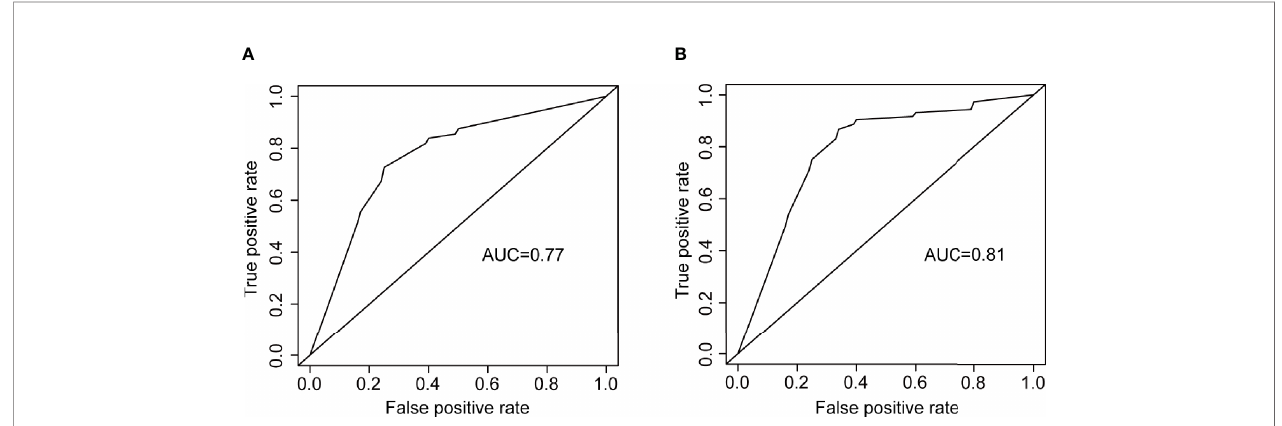
FIGURE 7 | The ROC curves of two logistic regression models for distinguishing DR participants from diabetes participants free of DR. (A) the logistic regression using systemic risk factors as independent variables. (B) the logistic regression using OCTA metrics as independent variables.